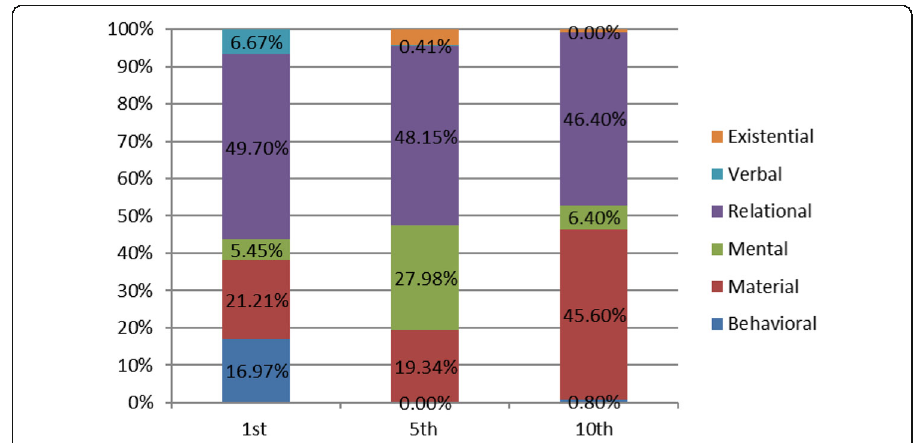
Fig. 4 Instantiation of process type in different writing